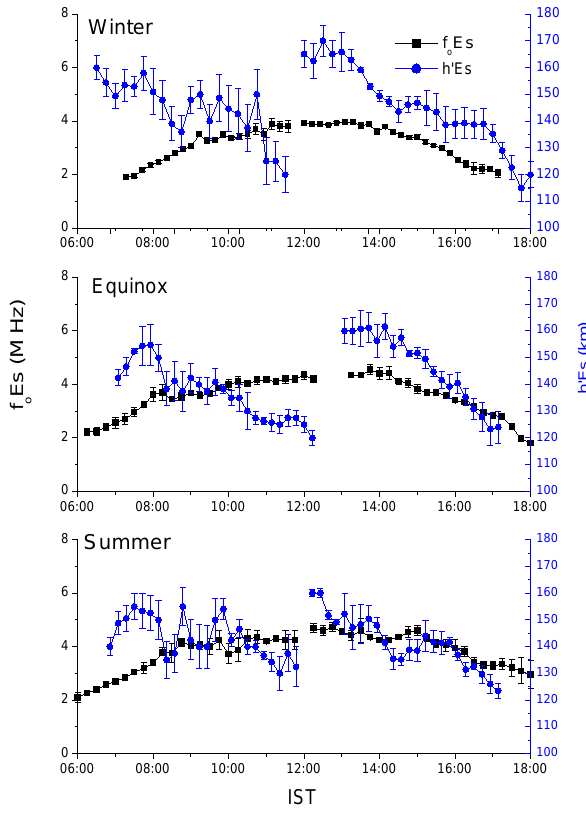
Fig. 5. Monthly mean seasonal variation of descending intermediate layer fo Es & h’Es during low solar activity year (2004) at Waltair.